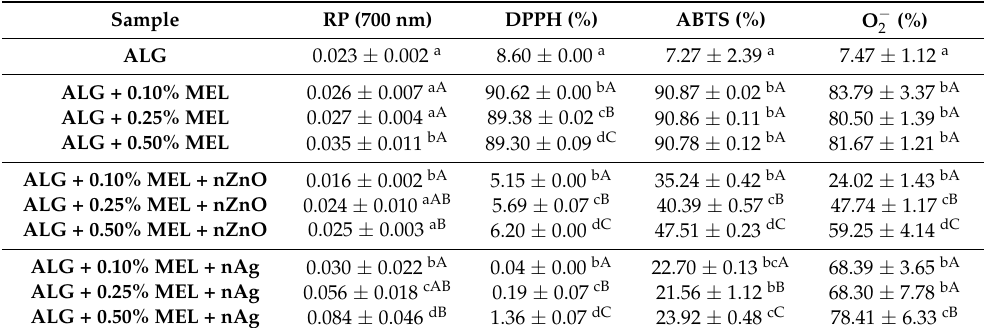
Table 5. Reducing power (RP) and radical (DPPH, ABTS, O − modified alginate